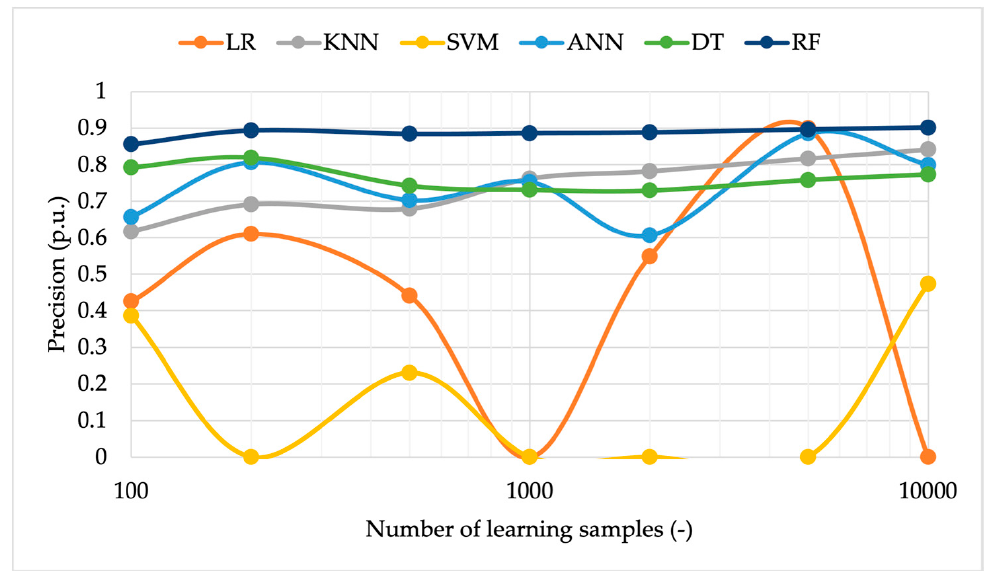
Figure 11. Algorithm precision vs. the number of learning samples using normal distributed inputs.